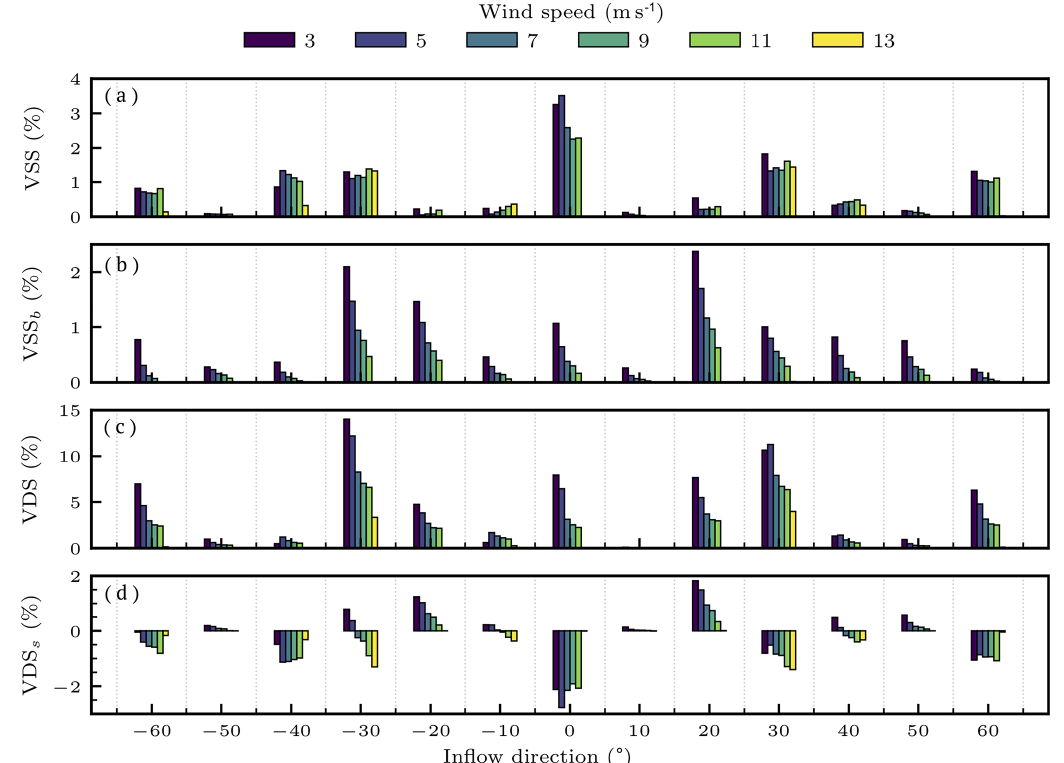
Figure 9. Summary statistics from Table 1 for varying inflow direction, θ , and wind speed, u ∞ , in the 11-turbine wind plant test case. Panels show VSS (a) , VSS b (b) , VDS (c) , and VDS s (d) , with different values of u ∞ indicated by different line colors (the legend is shown at the